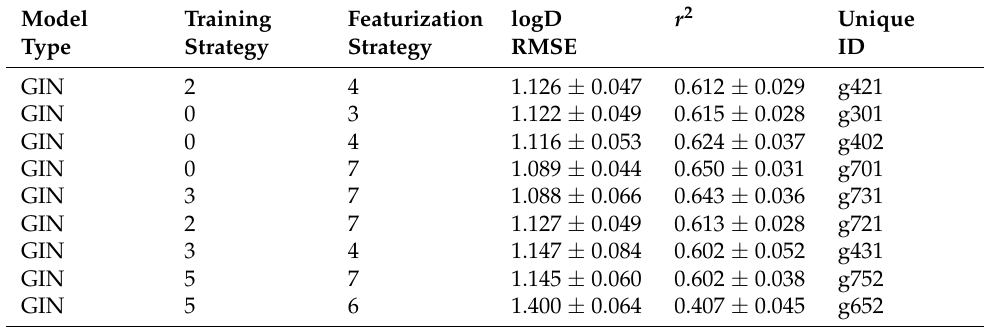
Table A14. Shows the logS RMSE and r 2 results for the GIN model type used during this survey. The last column consists of the unique identifier. Training strategy 0 represents a training strategy combining logD, logS, and logP, 1 represents a strategy combining logD and logP, 2 stands for a combination of logD and logS, 3 represents a strategy using logS and logP, 4 represents a strategy using logD, 5 represents a strategy using logS, and 6 represents a strategy using